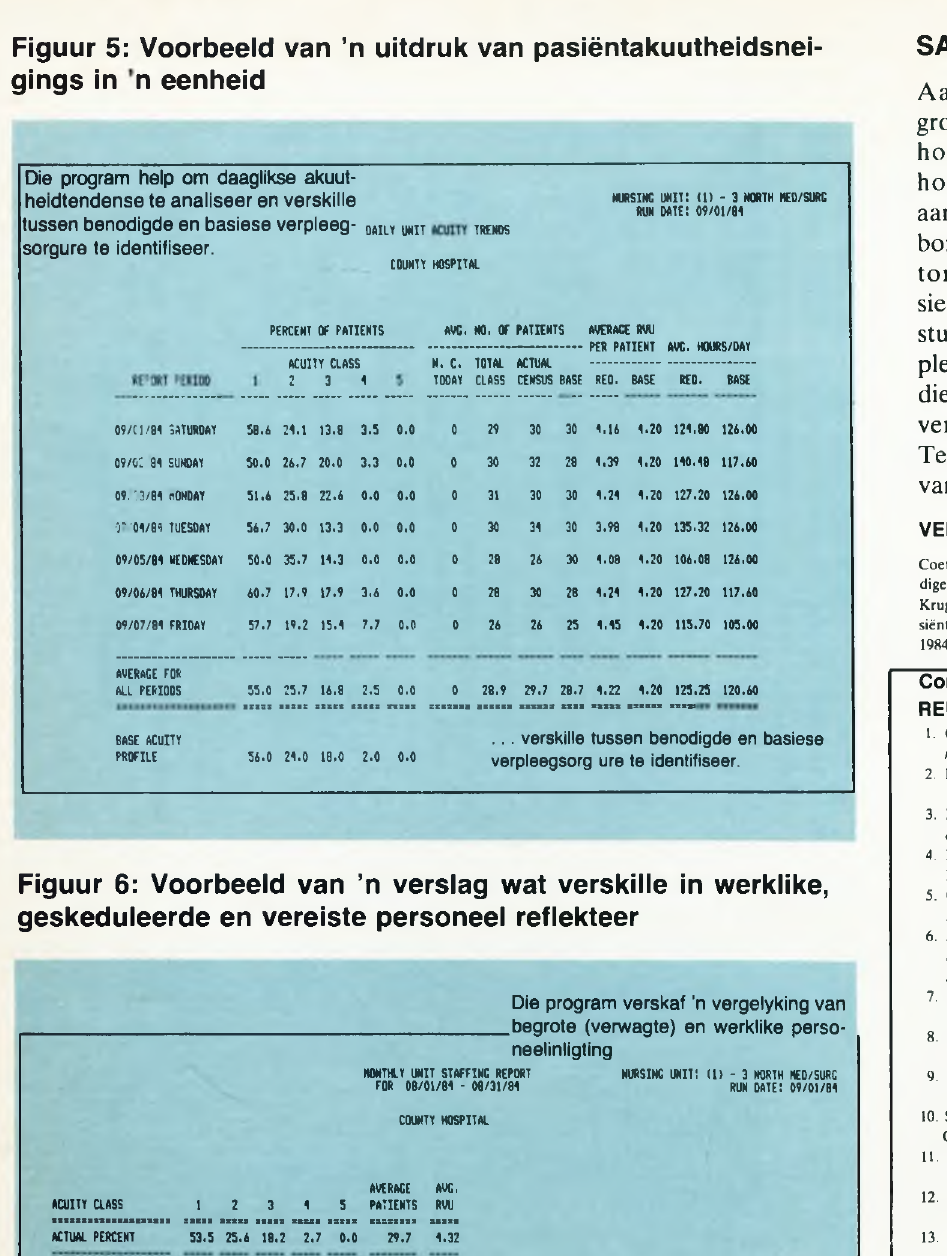
Figuur 6: Voorbeeld van ’n verslag wat verskille in werklike, geskeduleerde en vereiste personeel